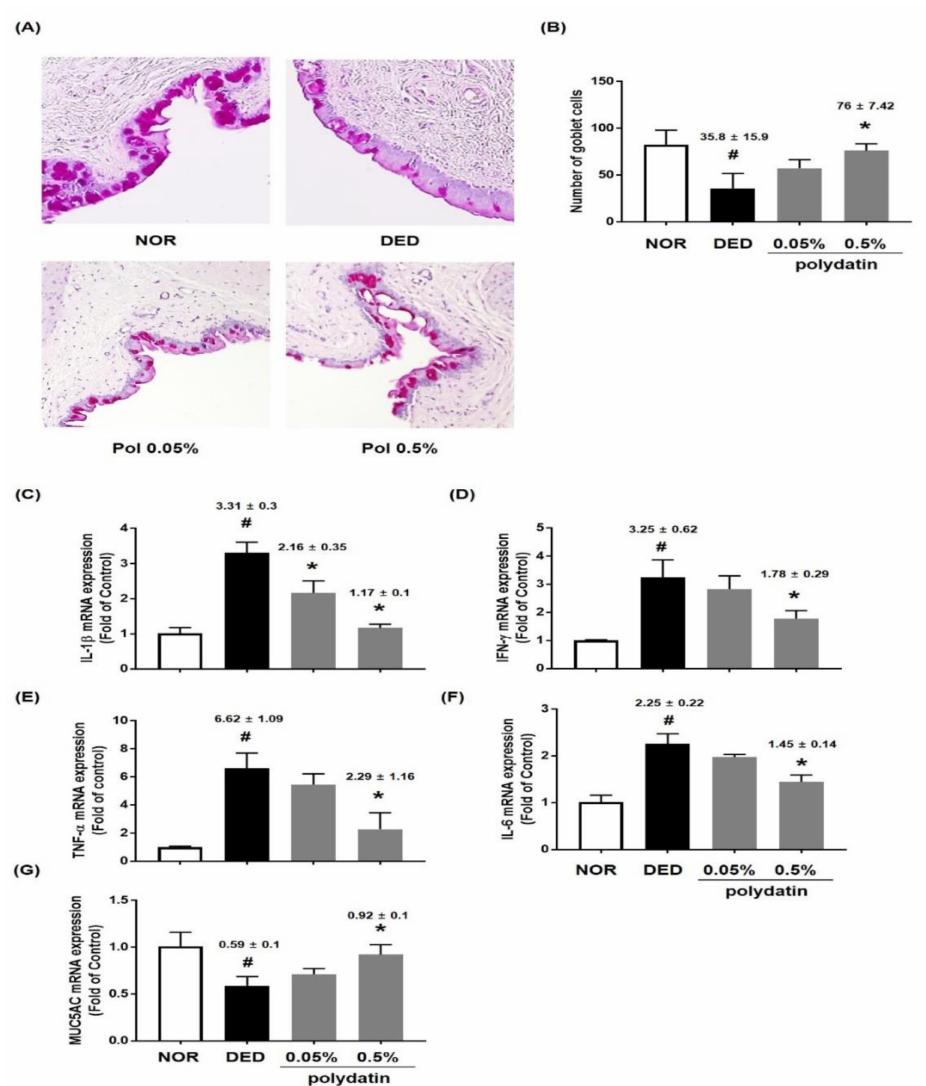
Figure 3. E ff ects of polydatin on conjunctival goblet cells in exorbital lacrimal gland-excised rats. ( A , B ) Histology by Periodic acid-Schi ff (PAS) staining of the conjunctival epithelium in exorbital lacrimal gland-excised rats. In the conjunctiva, epithelial cells and subepithelial fibroblasts are seen. PAS positive goblet cells were distributed in the conjunctival epithelium. Bar, 100 µ m. mRNA levels of ( C ) IL-1 β , ( D ) INF- γ , ( E ) TNF- α , ( F ) IL-6, and ( G ) MUC5AC were assessed by real-time PCR assay. GAPDH was considered an internal control. Data are the mean ± SEM of three independent experiments for all groups. # p < 0.05, significantly di ff erent from normal mice, * p < 0.05, significantly di ff erent from vehicle-treated dry eye